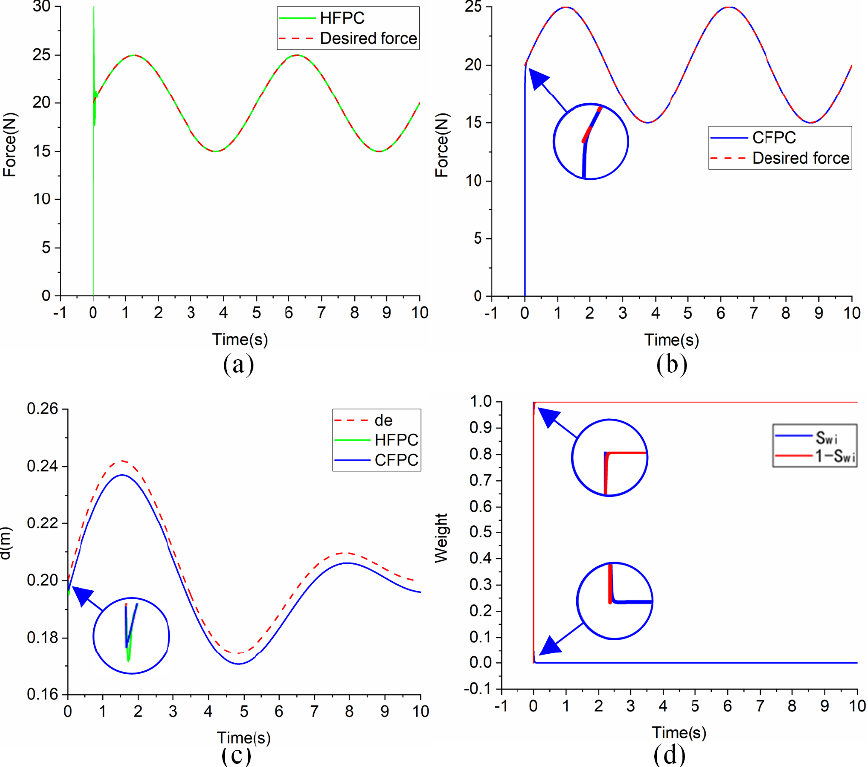
Figure 6. Simulations on complex surface. Force tracking using ( a ) the HFPC and ( b ) proposed CFPC methods. ( c ) Position tracking. ( d ) Weighted parameter wi s . Table 1. Simulation